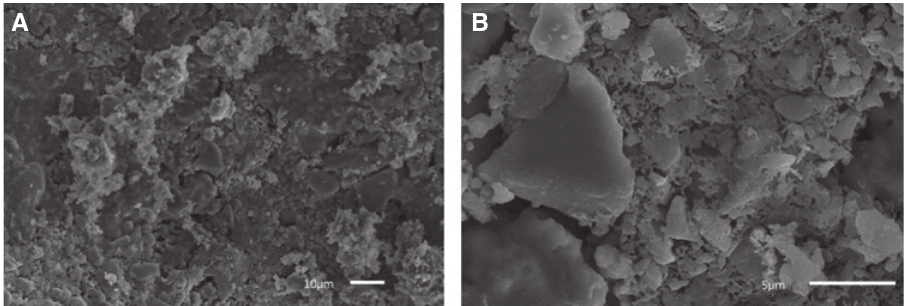
Figure 12: Surface morphology of D600 taken at different magnifications (A) × 1000 and (B) × 5000.